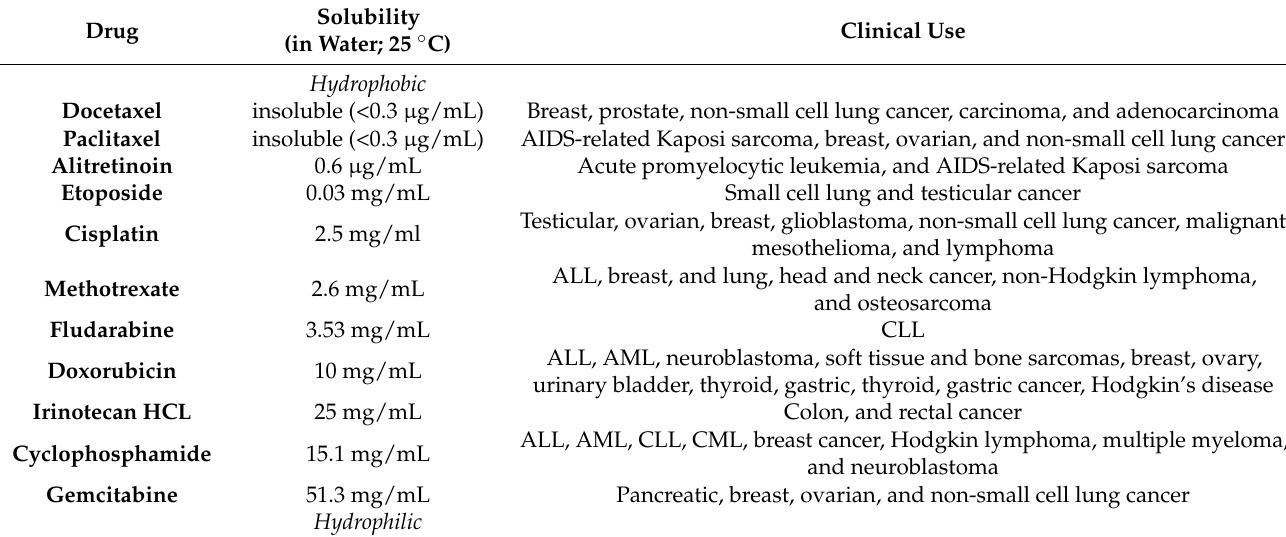
Table 1. Hydrophobic and hydrophilic anticancer drugs in clinical